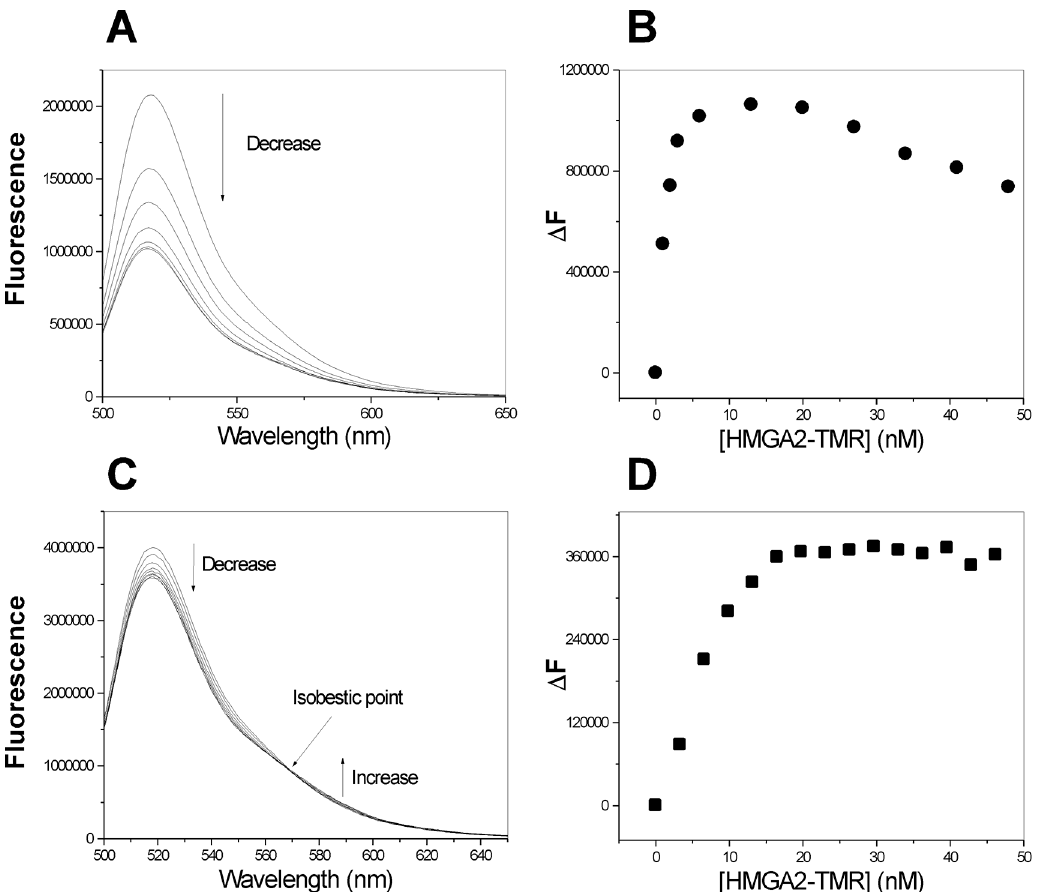
Fig 3. Self-association of HMGA2 was demonstrated by the FRET experiments. (A) and (C) , respectively, represent fluorescence spectra of HMGA2-FM in the presence of increasing concentrations of HMGA2-TMR in 50 mM Tris-HCl (pH 8.0) and 50 mM (A) or 200 mM (C) NaCl. (B) and (D) are the difference in fluorescence intensity at 518 nm ( Δ F) as a function of HMG-TMR concentration was shown for the FRET experiment in panel A and panel C respectively. The fluorescence spectra of HMGA2-FM (20 nM; λ excitation = 492 nm) were recorded as described under “ Materials & Methods.